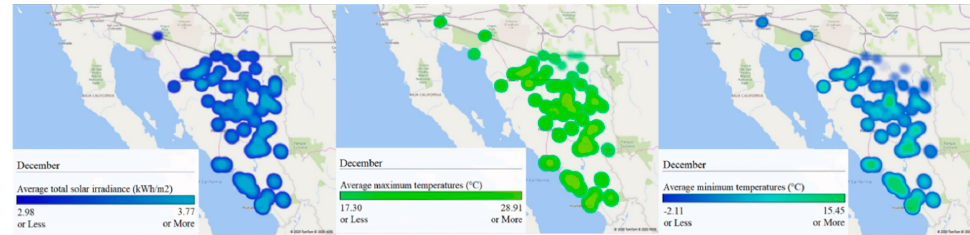
Figure 18. GIS analysis of Sonora for December: ( left ) average total solar irradiance (kWh/m 2 ), ( center ) maximum average temperatures (°C), and ( right ) minimum average temperatures (°C).